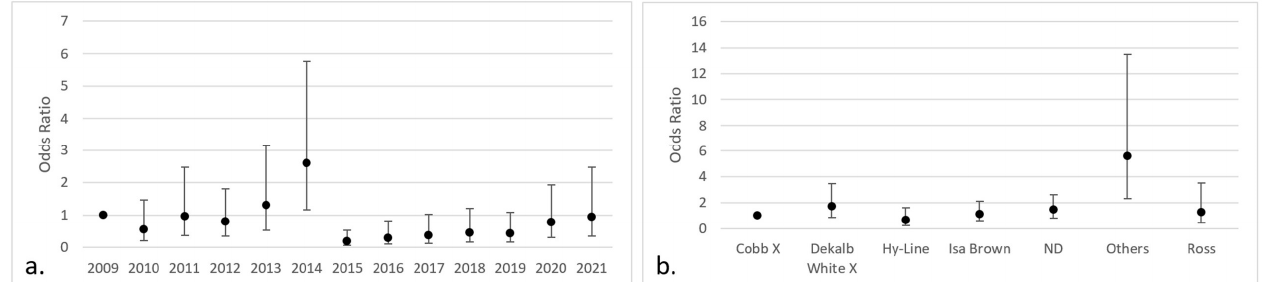
Figure 5. Categories with the highest risk of positive isolates for Aspergillus section Fumigati (95% CI) in chicken lungs ( Gallus gallus ) from 2008 to 2021 in the Mycology Laboratory, School of Veterinary Medicine, Universidad Nacional, Heredia, Costa Rica. ( a ) Year of remission; ( b ) bird breed. 2009 includes 2008; Cobb X = pure Cobb mixed with Hubb and Ross; Dekalb White X = pure Dekalb White mixed with Isa Brown; ND = non-determinate breed; Others = Redbro, Sasso, Hubbard, and Lohman.